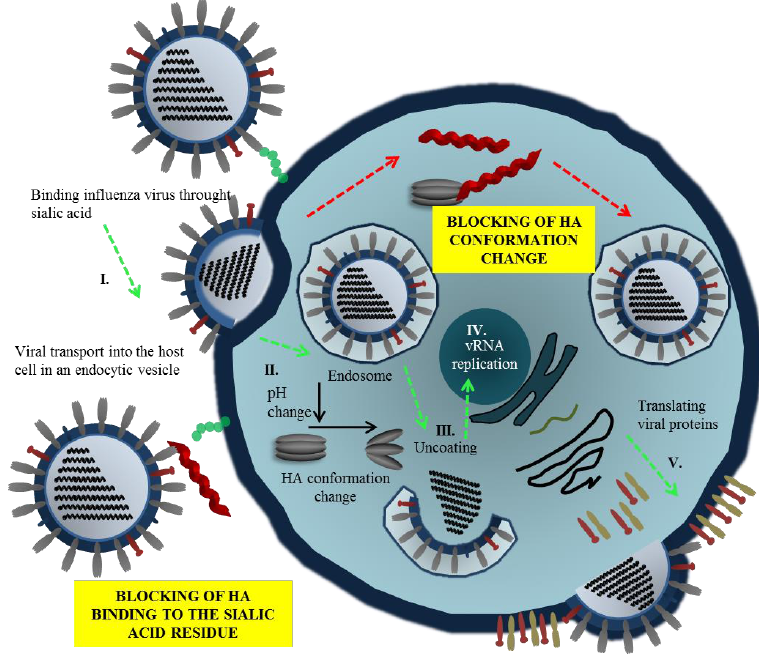
Figure 2. Mechanisms of inhibition of virus entry by peptides. Viral entry can be blocked via interaction of peptide with hemagglutinin (HA), commonly interacting with residue of sialic acid. This phenomenon results in the alteration of HA functions, and thus influenza virion cannot be attached to the membrane of a host cell. The second antiviral action of peptides may be carried out and dissemination of viral